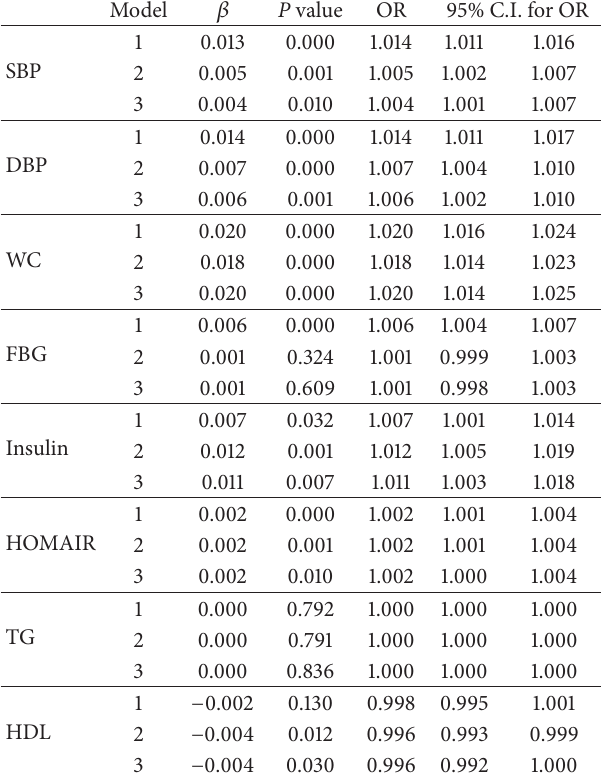
Table 1: Univariate binary logistic regression analysis: dependent variable is thyroid